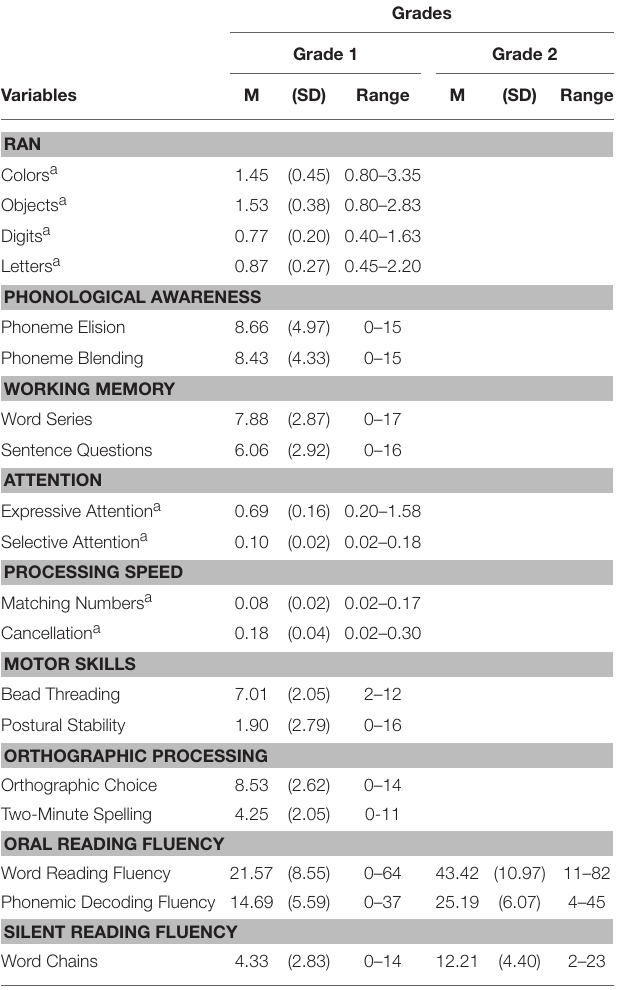
TABLE 1 | Descriptive statistics on RAN, Phonological ability, Working Memory, Attention, Processing Speed RAN, Memory, Semantics, Reading, and Orthographic